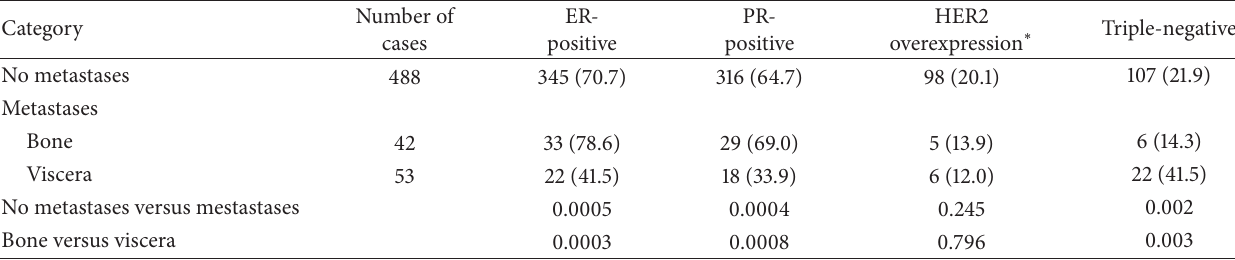
Table 3: Pattern of metastatic spread for tumors with known steroid receptor status and HER2 overexpression.